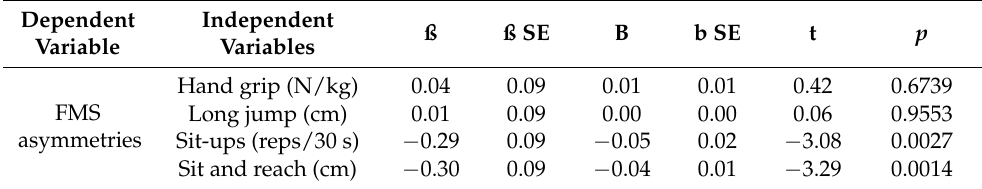
Table 4. Multiple regression results for FMS asymmetries